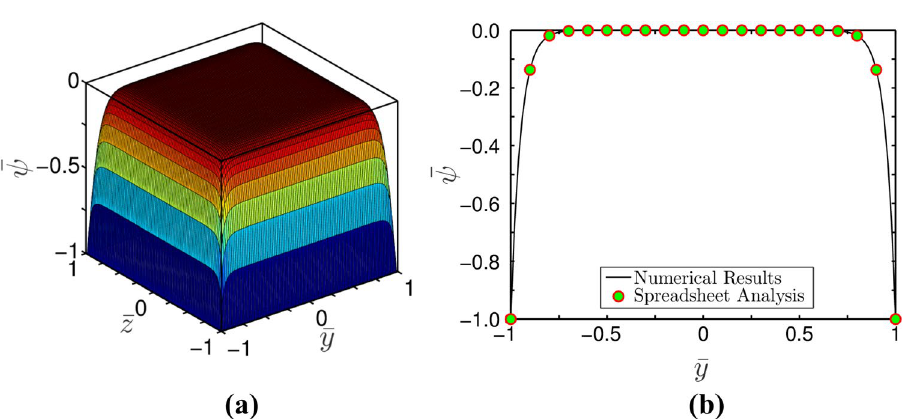
Figure 6. Plots depict potential distribution profile for κ = 20 : ( a ) Three-dimensional potential distribution using Spreadsheet analysis tool, and ( b ) Potential distribution profile at z = 0 using both MATLAB and Spreadsheet analysis